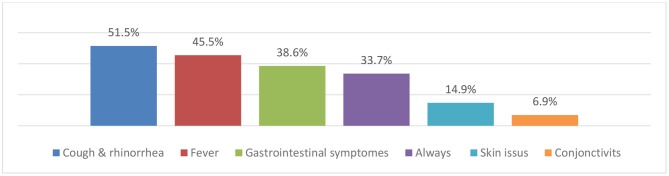
Chief complaints for which a follow-up is requested after a telephone prescription, n = 101.